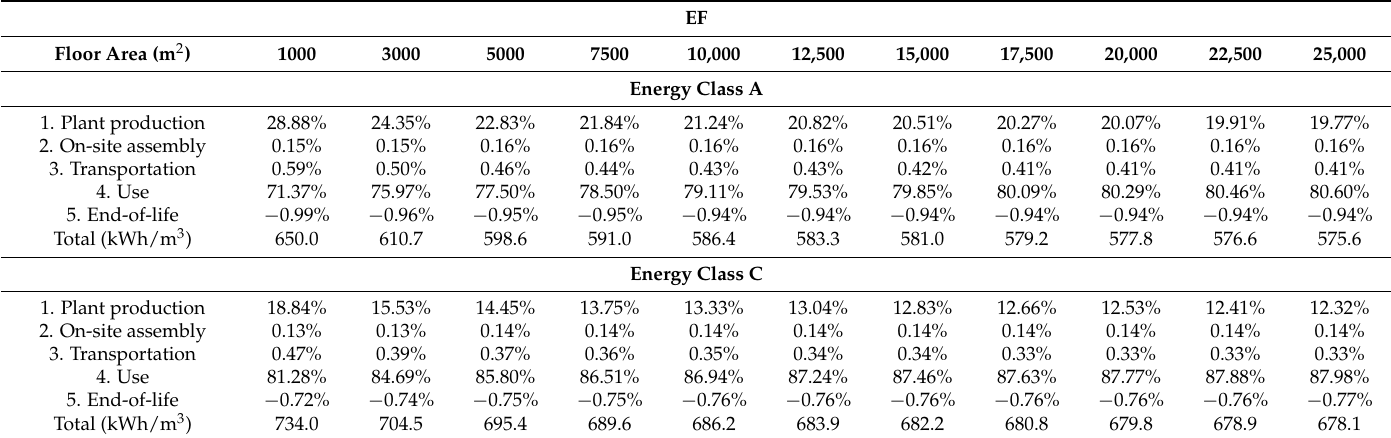
Table 7. EF: enhanced vs . standard